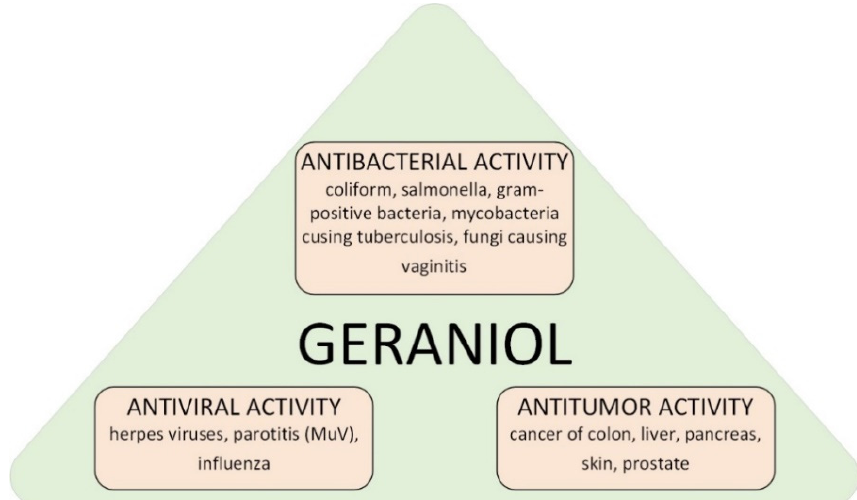
Figure 1. Possible ways of applications of geraniol in medicine.